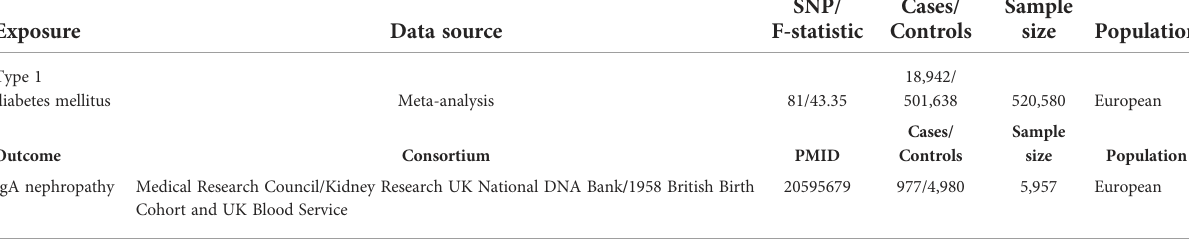
TABLE 2 Characteristics of type 1 diabetes mellitus and IgA